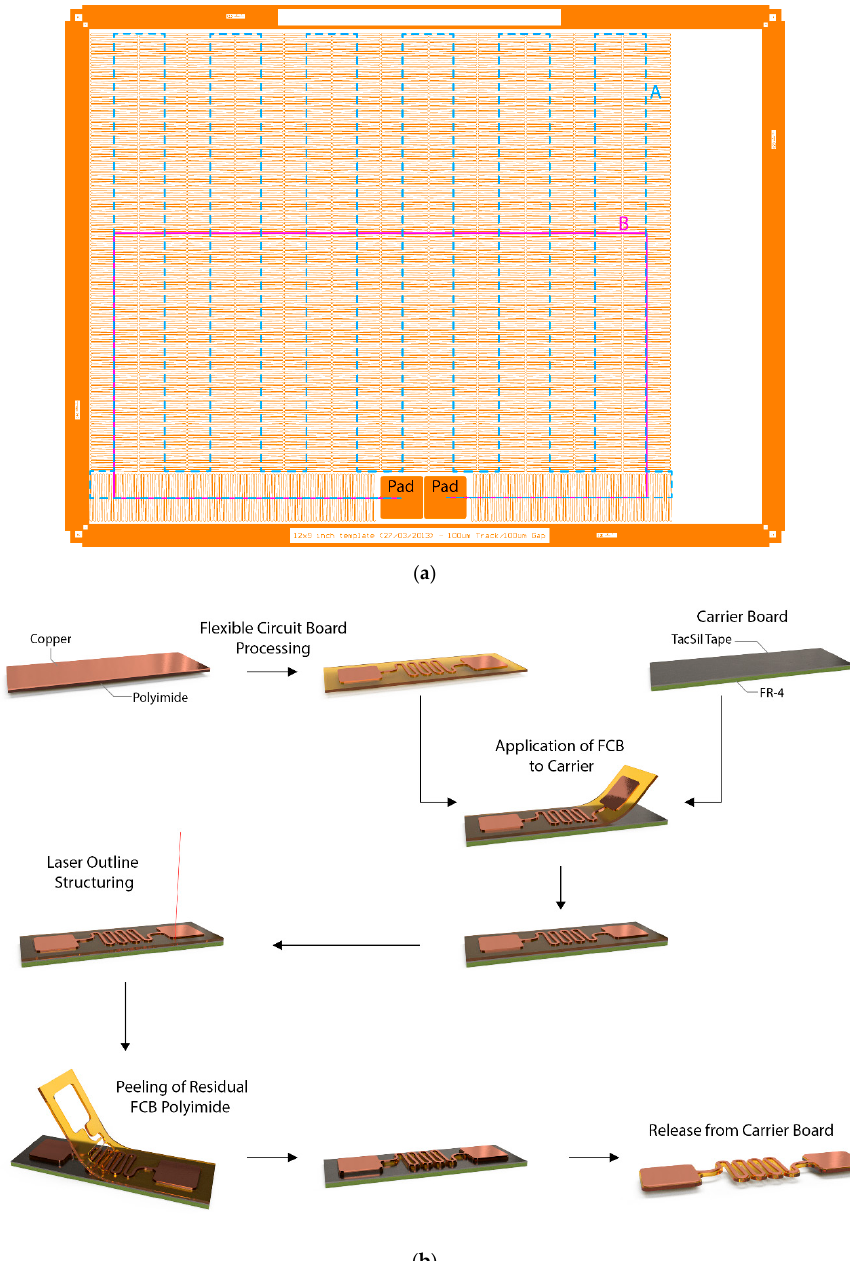
Figure 1. Manufacturing of free-standing stretchable circuits. ( a ) Copper artwork of the manufactured stretchable circuit. ( b ) Process flow used to manufacture the stretchable circuits. First, a flexible copper clad laminate is patterned using photolithography and wet etching. The resulting flexible circuit board (FCB) is then applied to an FR-4 carrier board covered with a pressure-sensitive TacSil Tape adhesive for mechanical support. The outline of the meanders and connection pads is then defined by cutting